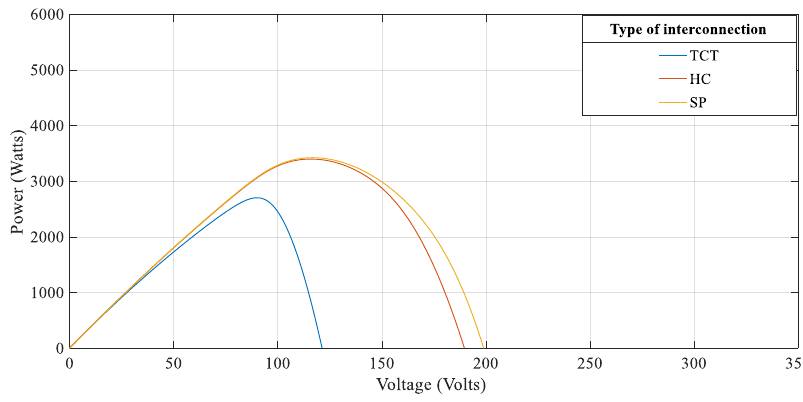
Figure 10. P-V curve for short circuit fault ‘F2′ (thin-film PV).